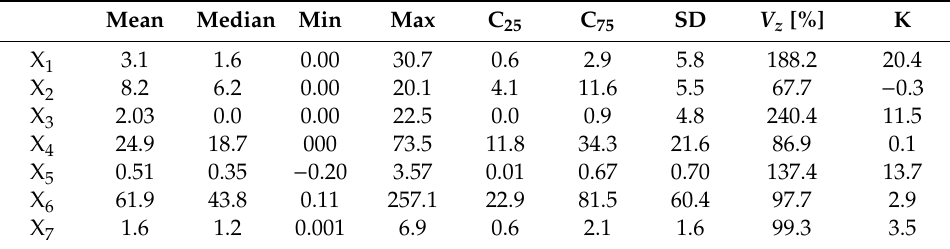
Table 1. Basic descriptive statistics of the selected